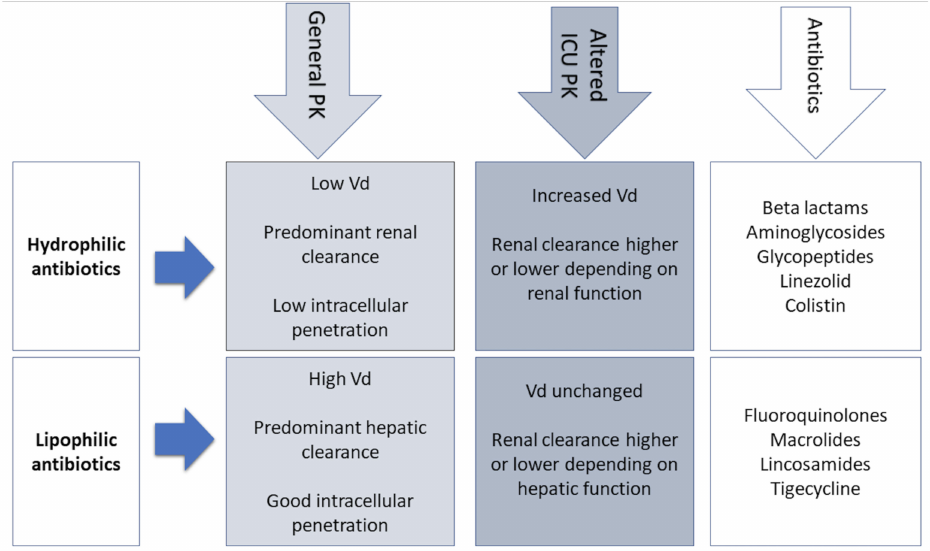
Figure 1. Physicochemical properties of antibiotics. Vd—Volume of distribution;